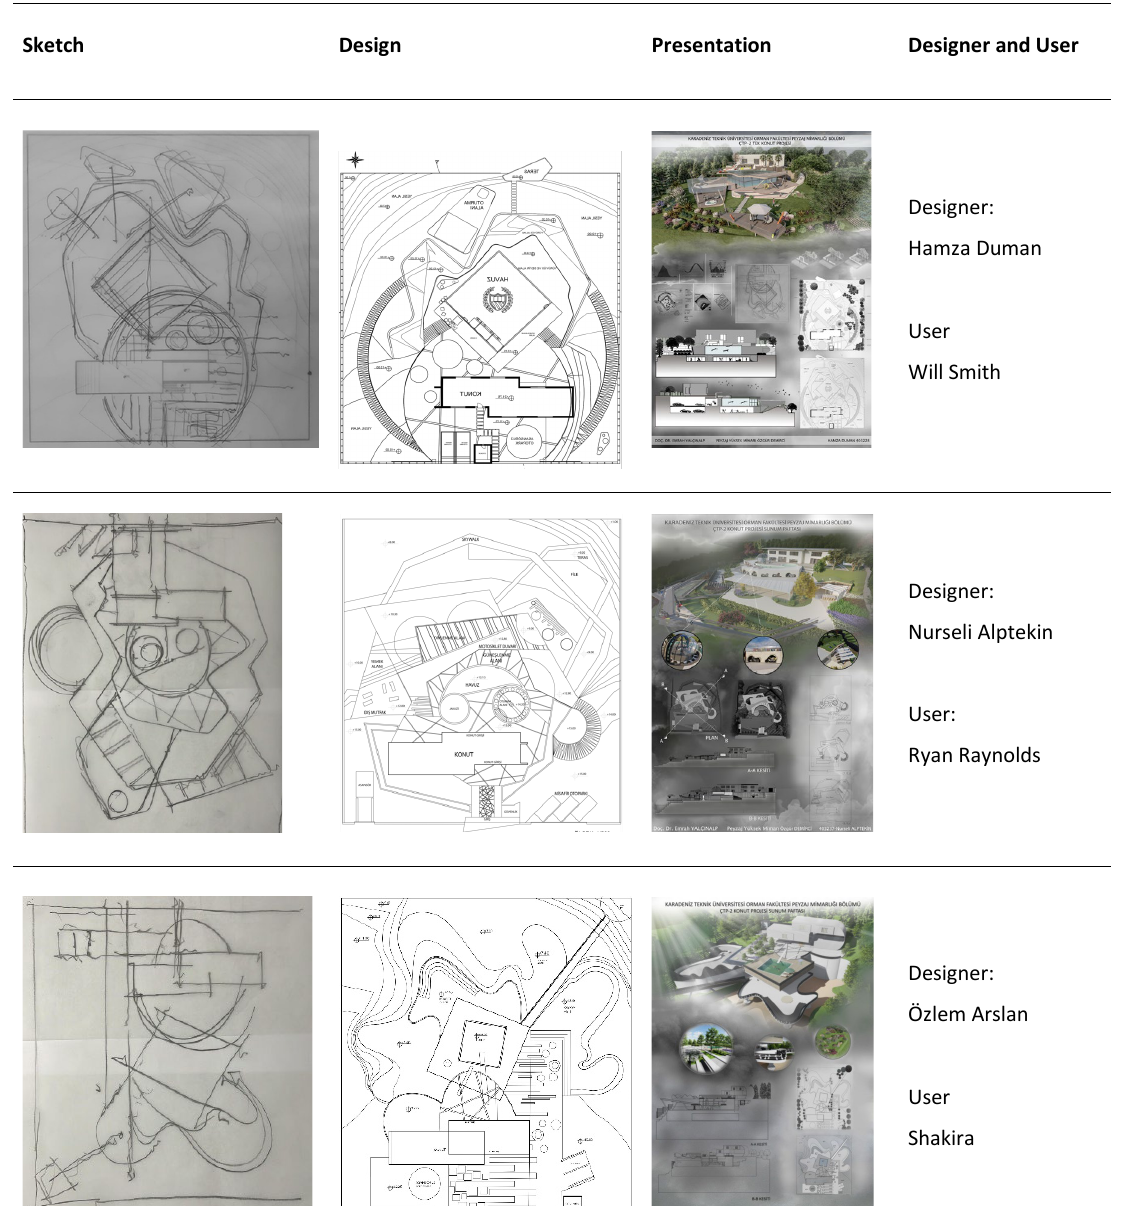
Table 1 Sketchs, designs, presentations, designers and